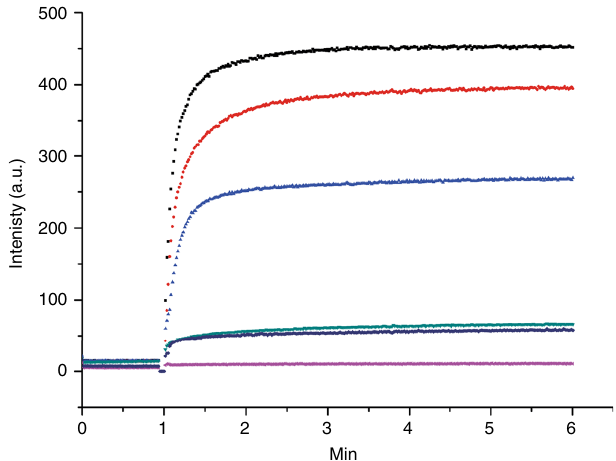
Fig. 4 Transport of different cations by ZntB. Transport of different cations (added at 1 min and colour-coded: black — 20 µ M Zn 2+ , red — 20 µ M Cd 2+ , blue — 100 µ M Ni 2+ , green — 200 µ M Co 2+ , dark blue — empty liposomes with 20 µ M Zn 2+ , magenta — empty liposomes with 200 µ M Co 2+ ) assayed by the fl uorophore Fluozine-1 trapped inside the